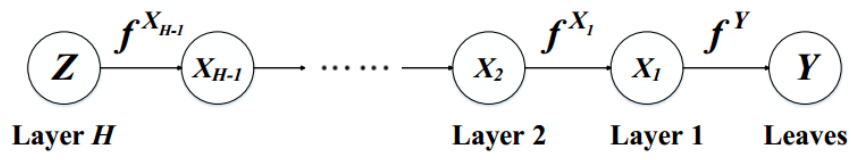
Figure 1. Deep Gaussian Process architecture